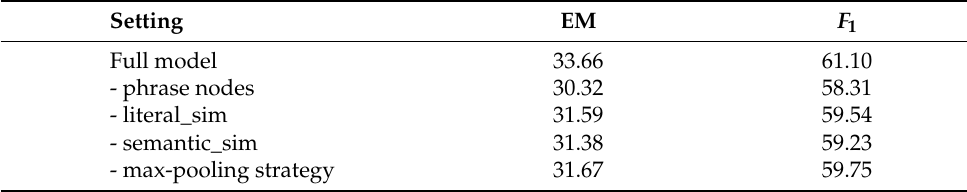
Table 4. Performance results of ablation